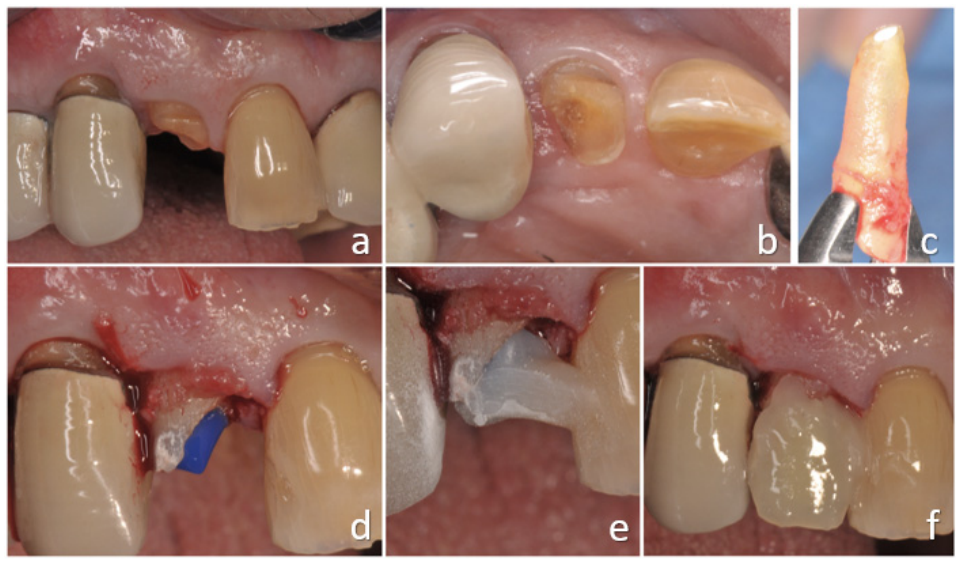
Figure 3. Surgical extrusion of tooth 1.2 with insufficient ferrule effect ( a , b ). Tooth was extracted with an atraumatic method ( c ) and then reimplanted and splinted, waiting for healing ( d – f ).